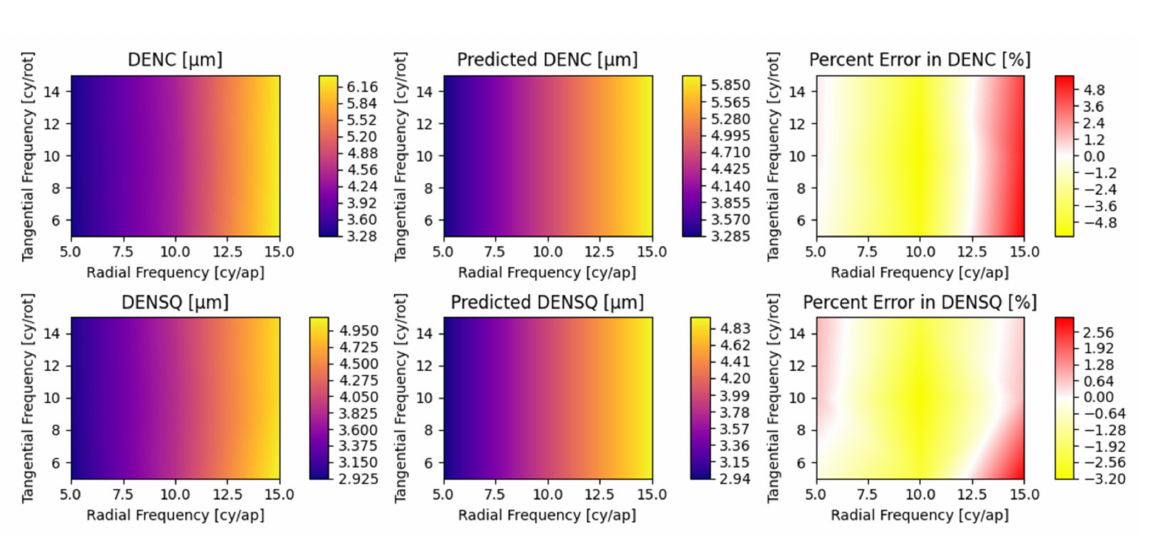
Figure A8. Radial Frequency versus depth frequency. (3 × 3 sampling matrix, κ = ω = δ = 0, η = 0.15, σ = 0.05, θ = 45 ◦ ).